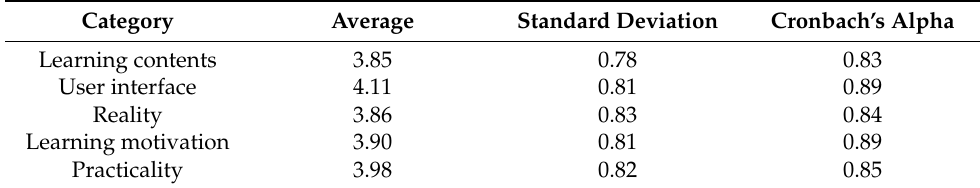
Table 9. Average, standard deviation, and Cronbach’s alpha for each